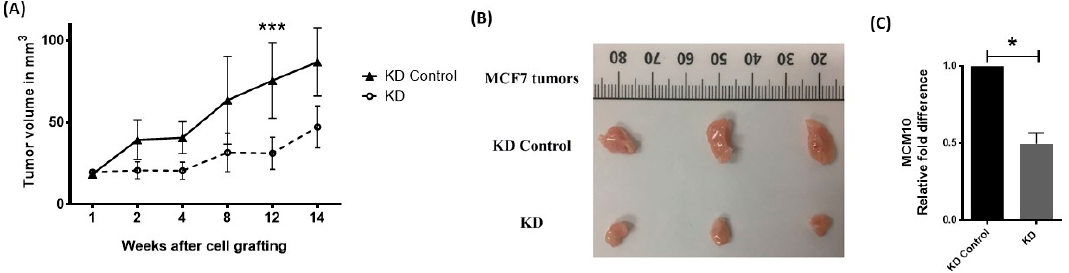
Figure 6. Effect of MCM10 knockdown in tumor progression in vivo. ( A ) tumor growth monitored by tumor volume measurement and showed a significant difference at the 12th week after grafting MCM10-KD MCF7 cell ( n = 12, *** p < 0.001); ( B ) representative tumors at 14 weeks after grafting; ( C ) relative quantification of MCM10 in mice tumors ( n = 3, * p < 0.05).